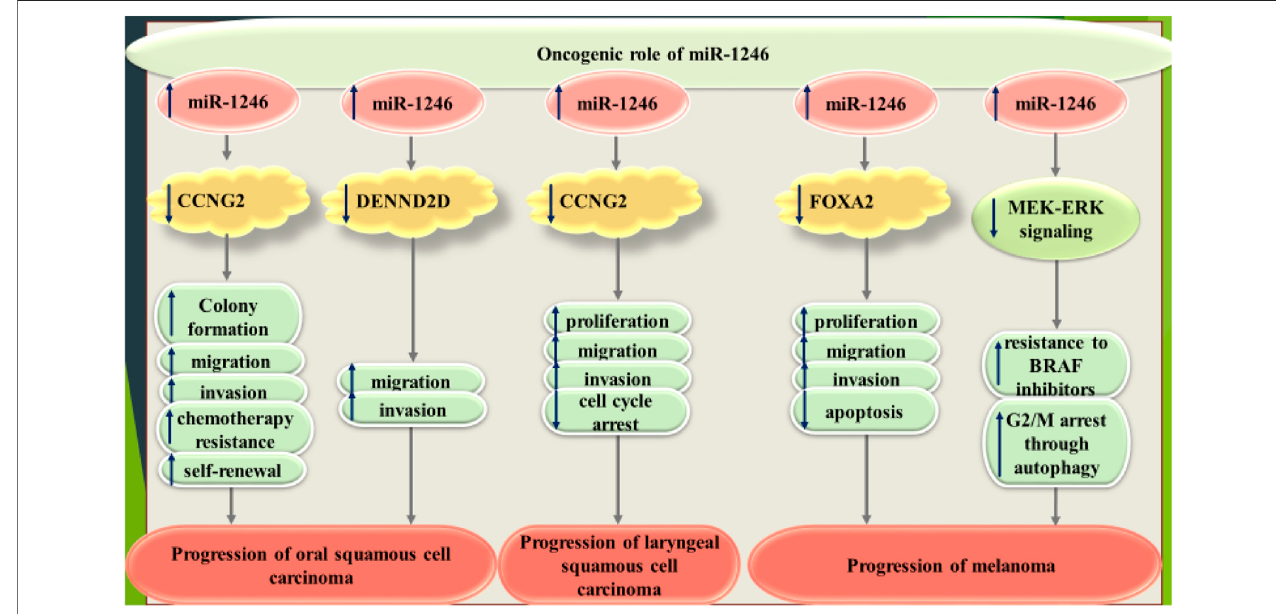
FIGURE 5 | Oncogenic role of miR-1246 in oral and laryngeal squamous cell carcinomas and melanoma.